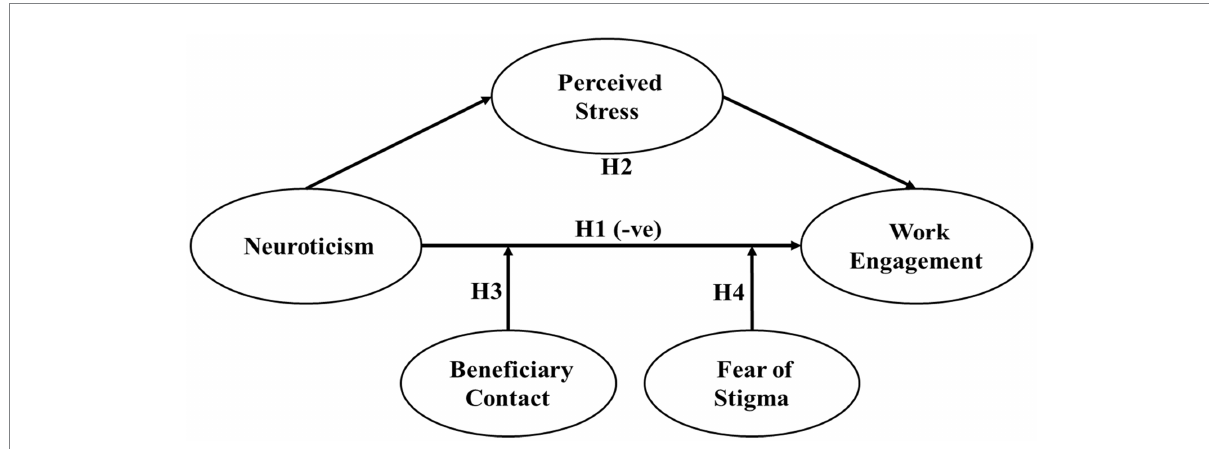
FIGURE 1 Hypothesized model. H1 indicates a negative relationship between neuroticism and work engagement; H2 indicates the indirect effect of neuroticism on work engagement through perceived stress. H3 and H4 indicate the moderation effect of beneficiary contact and fear of stigma, respectively, on the negative relationship between neuroticism and work